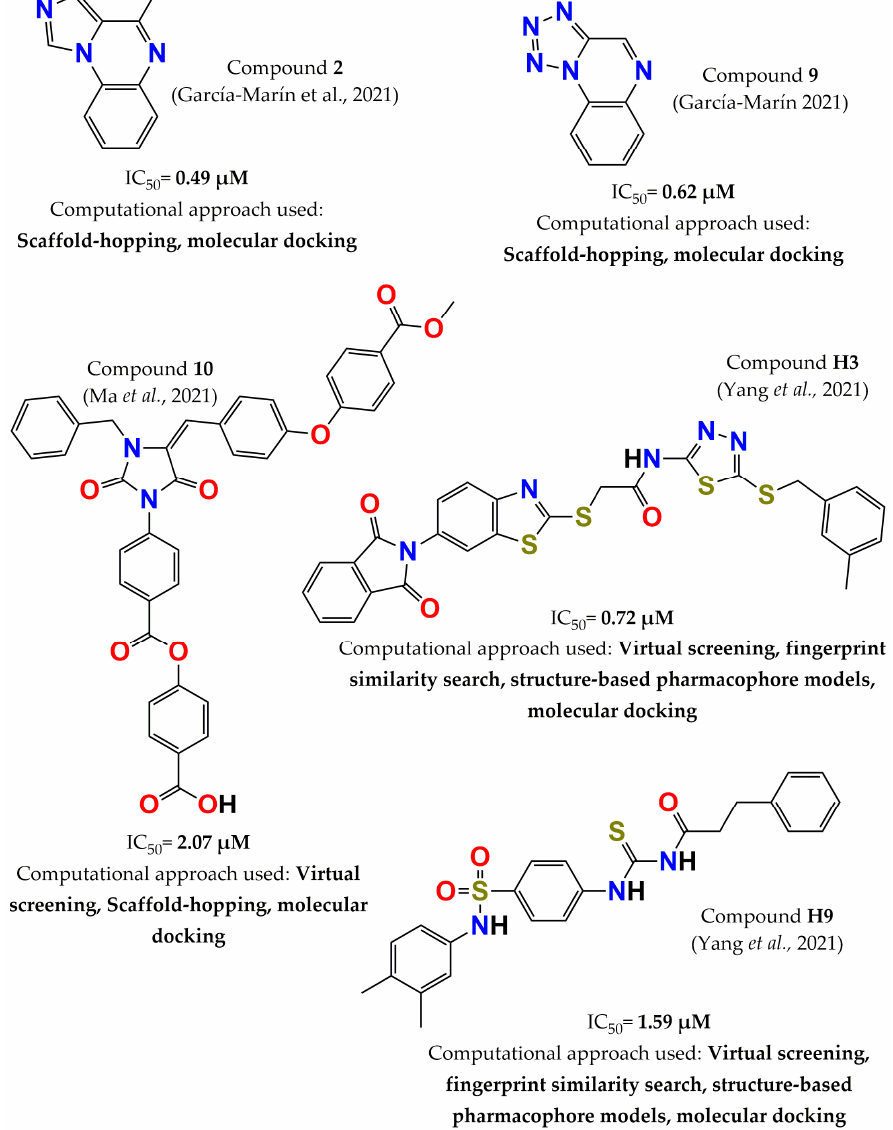
Figure 11. Structure of the most potent PTP1B inhibitors reported in 2021 discovered through com- putational approaches. computational